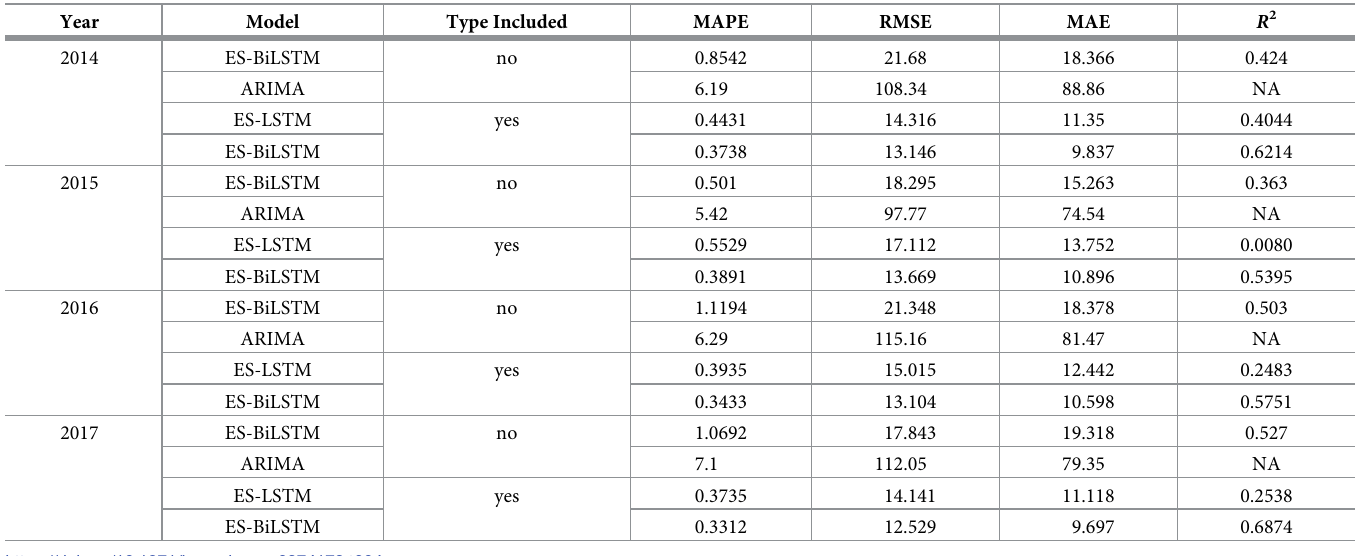
Table 4. The results of forecasting the number of crimes hourly for the two models using two methods.